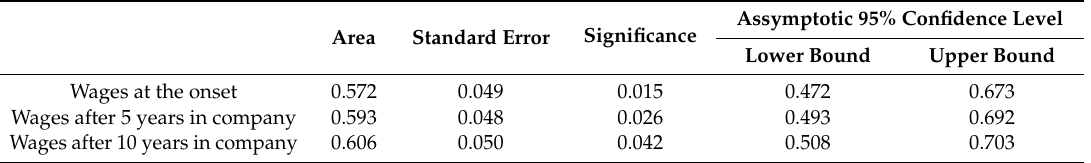
Table 5. Results of gross wage defined under ROC